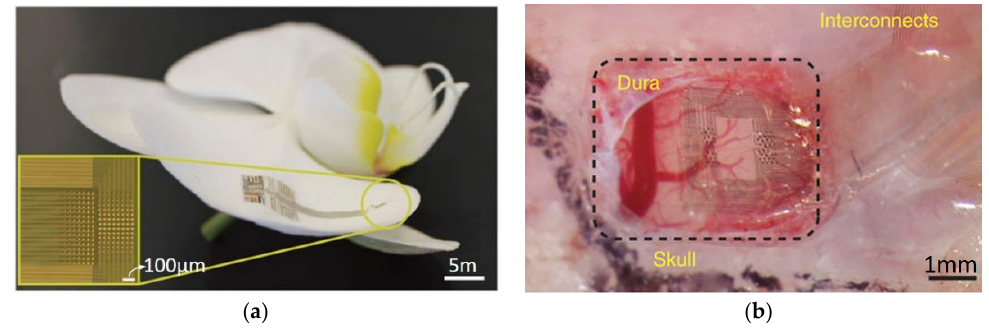
Figure 6. ( a ) Flexible and organic ECoG conforms to the surface of an orchid petal. Inset, optical micrograph of a 256-electrode ECoG. Electrodes are 10 × 10 µm 2 with 30-µm interelectrode spacing; ( b ) Flexible and organic ECoG conforms to the surface of the rat somatosensory cortex. The edge of the resected dura is visible at top left of the craniotomy. Reprinted by permission from Macmillan Publishers Ltd.: Nature Neuroscience [115], copyright 2014.